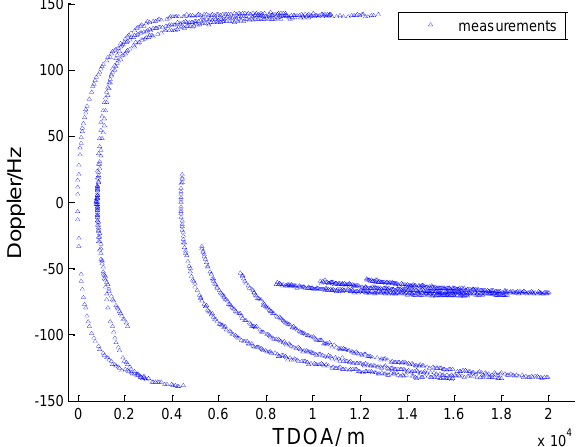
Figure 5. Measurements for three targets without clutter,